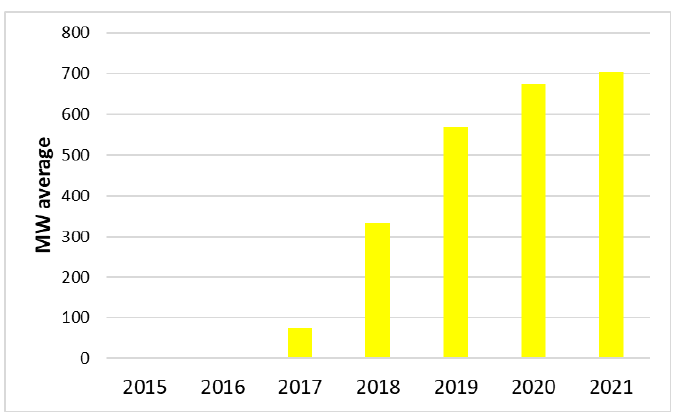
Figure 2. Solar generation in Brazil. Reproduced from [5], National Electric System Operator: 2021.